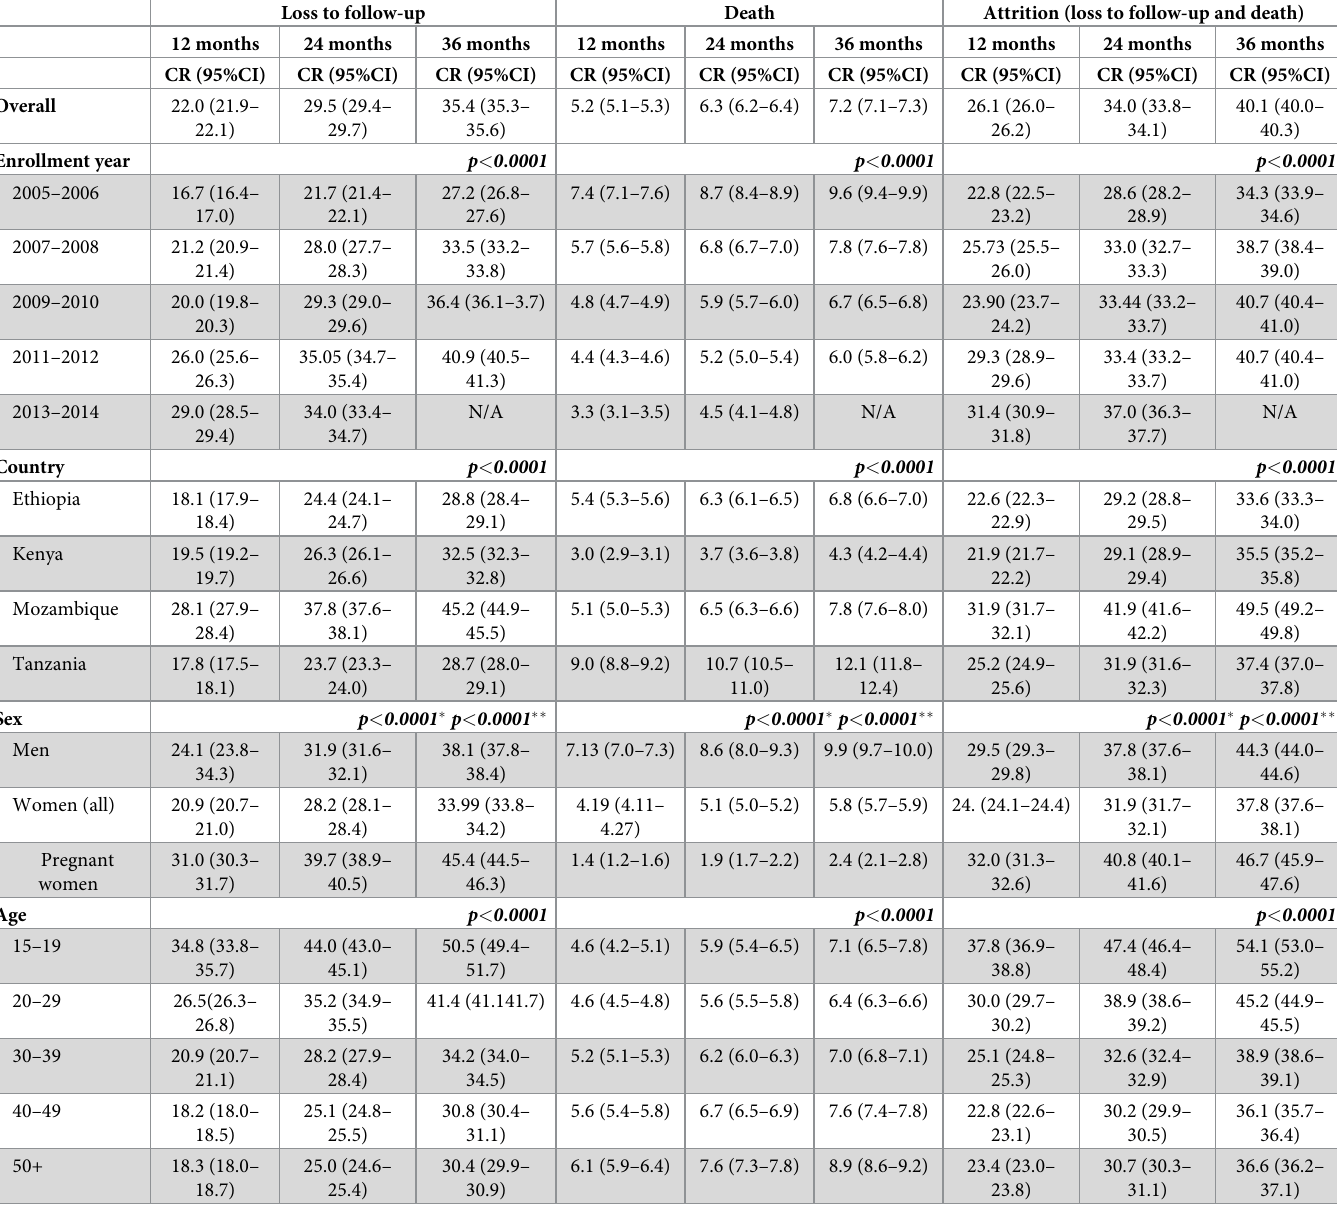
Table 3. Cumulative risk of loss to follow-up, death and combined attrition for adults ( > = 15 years) after ART initiation enrolled at ICAP-supported health facili- ties in Ethiopia, Kenya, Mozambique and Tanzania 2005–2014 (N = 432,817). Loss to